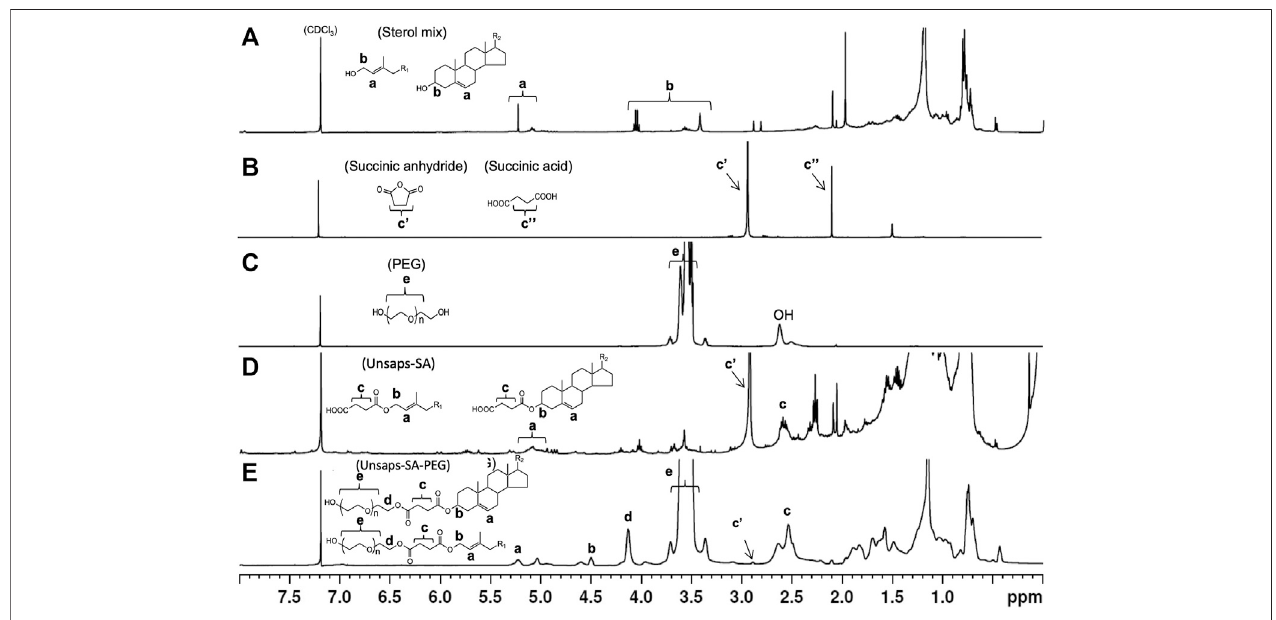
FIGURE 4 | 1 H-NMR spectra of (A) sterol mixture, (B) succinic anhydride, (C) PEG, (D) unsaponi fi ables-SA, and (E) unsaponi fi